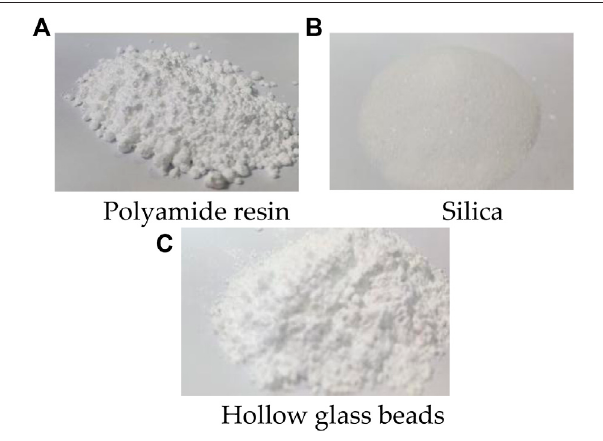
FIGURE 8 | Tracer particles. (A) Polyamide resin (B) Silica (C) Hollow glass